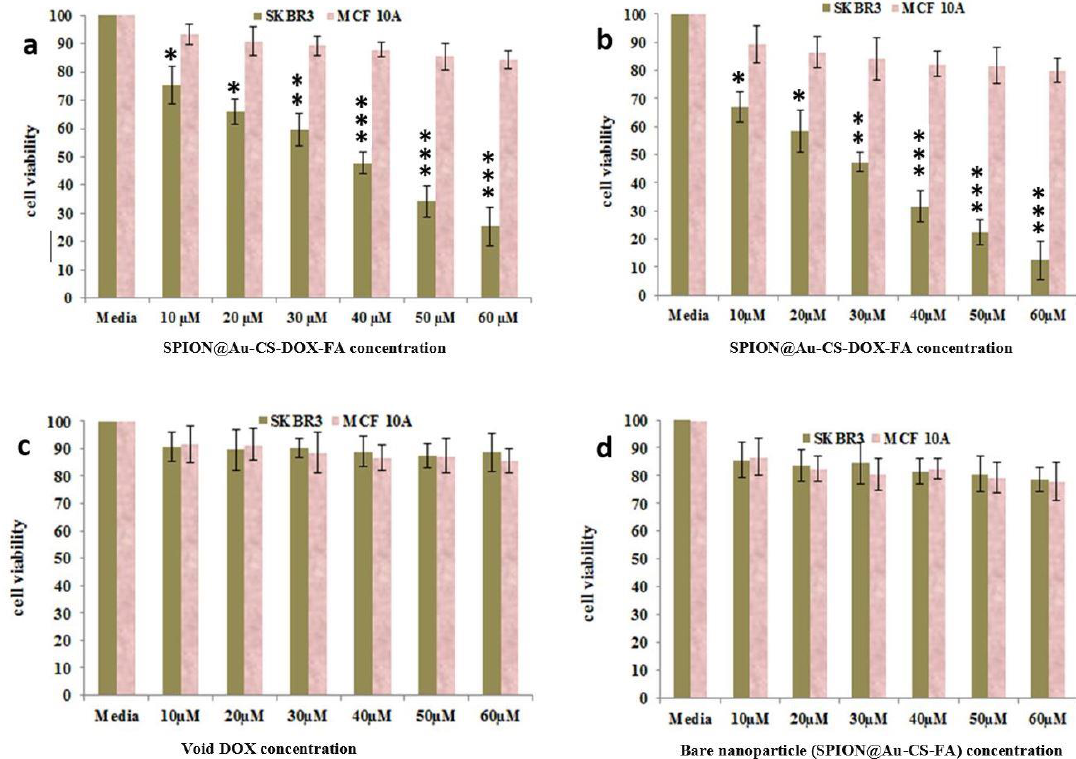
Figure 4. Cell toxicity evaluation of SPION@Au-CS-DOX-FA nanoformulation by the MTT assay on SKBR3 and MCF-10A cell lines with 24 h ( a ), 48 h ( b ) incubations. The cells also treated with void DOX ( c ) & bare SPION@Au-CS-FA nanoparticle ( d ) with same concentrations for 48 h. (mean ± S.D., (* p < 0.05; ** p < 0.01; *** p < 0.001); n = 3).